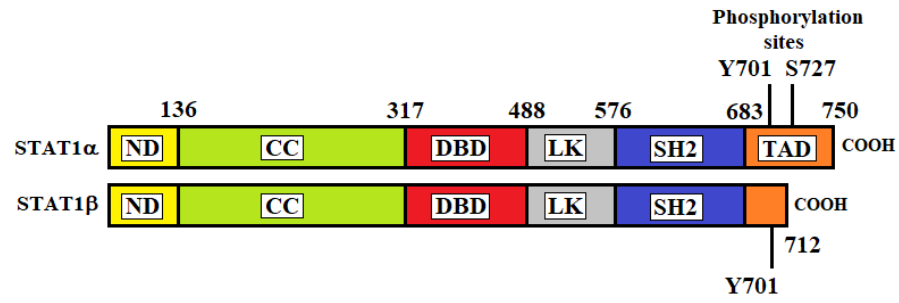
Figure 1. Structures of STAT1 α and STAT1 β . ND, N-terminal domain; CC, coiled-coil domain; DBD, DNA binding domain; LK, linker domain; SH2, Src homology-2 domain; TAD, transactivation do- main.